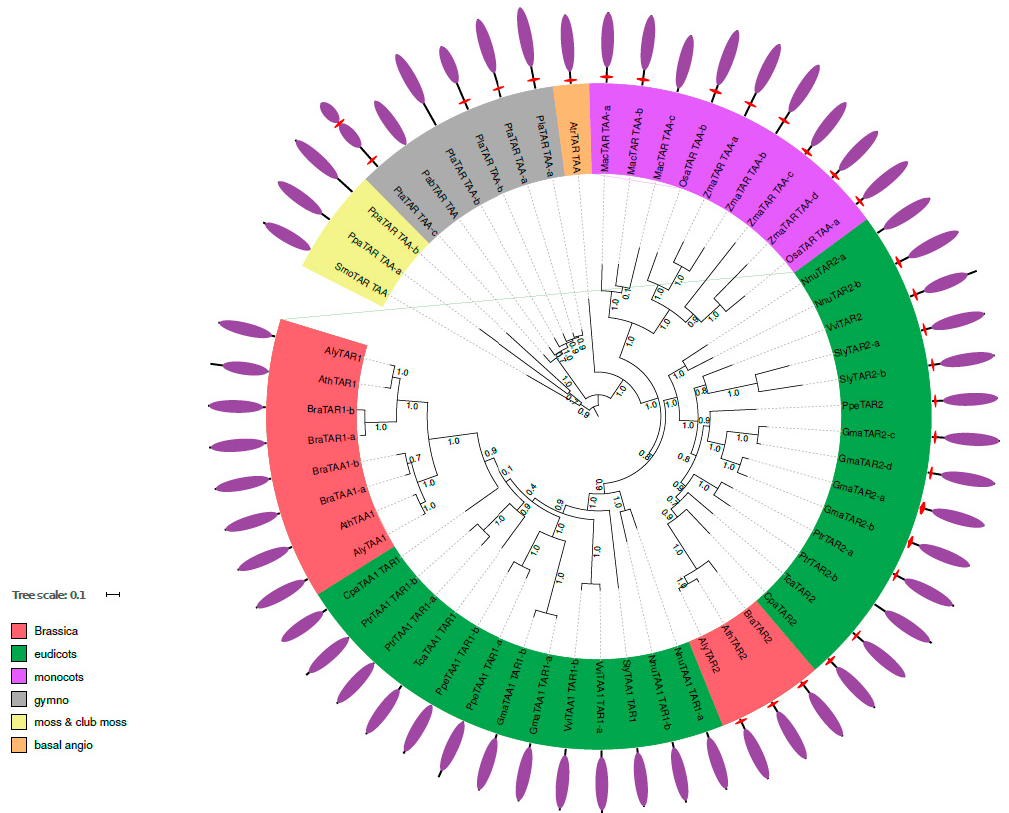
Figure 4. Phylogenetic tree of TAR1, TAR2 and TAA1 homologous proteins. Fast-tree using the maximum likelihood method [16] was used to create the phylogenetic tree for TAR1, TAR2 and TAA1 protein homologues constructed from MUSCLE alignment [18]. Bootstrap values are indicated on the branches of the phylogenetic tree. Gene labels are constructed with the three letters from the species name (Table 1) and the gene name of the A. thaliana homologue (Table S1). The colour of the label shows the lineage of the plant. The corresponding protein domains (circle periphery) are obtained using InterProScan [15], red hexagons represent the TMD in the protein if applicable and purple ellipses represent tryptophan aminotransferase domain.